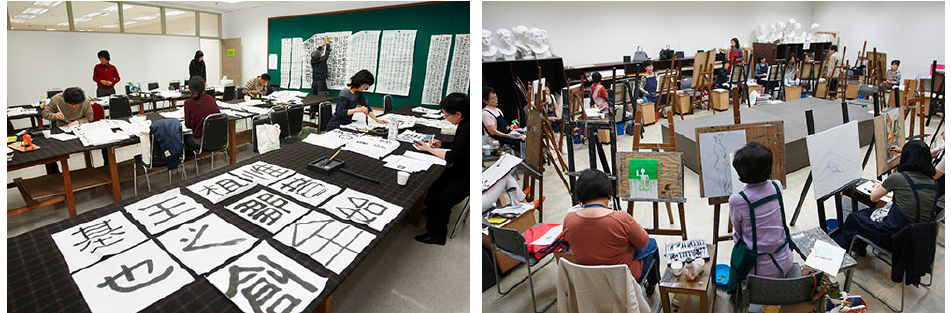
Figure 1. Scene of calligraphy and art academy education.